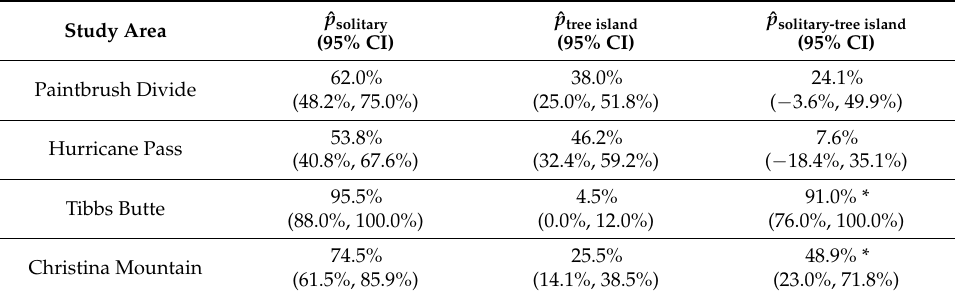
Table 2. Community structure parameter estimates.